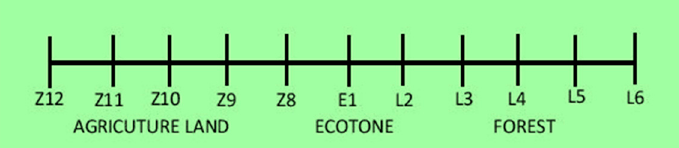
Figure 2. Study spots distribution scheme.